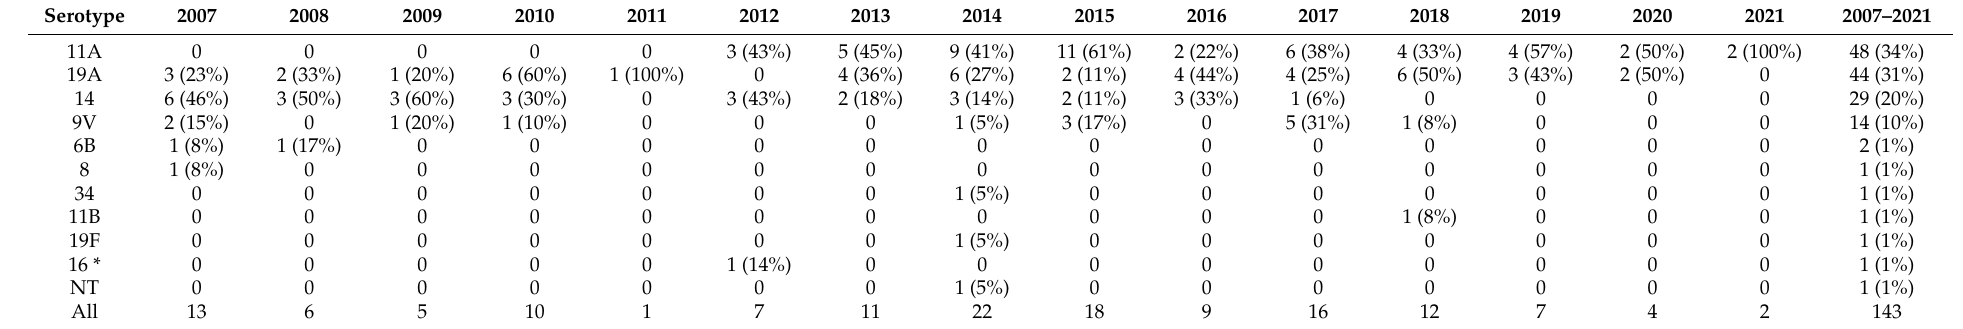
Table 3. Evolution of PENR S. pneumoniae invasive strains (number and %) according to serotype (region of Madrid, 2007–2021).